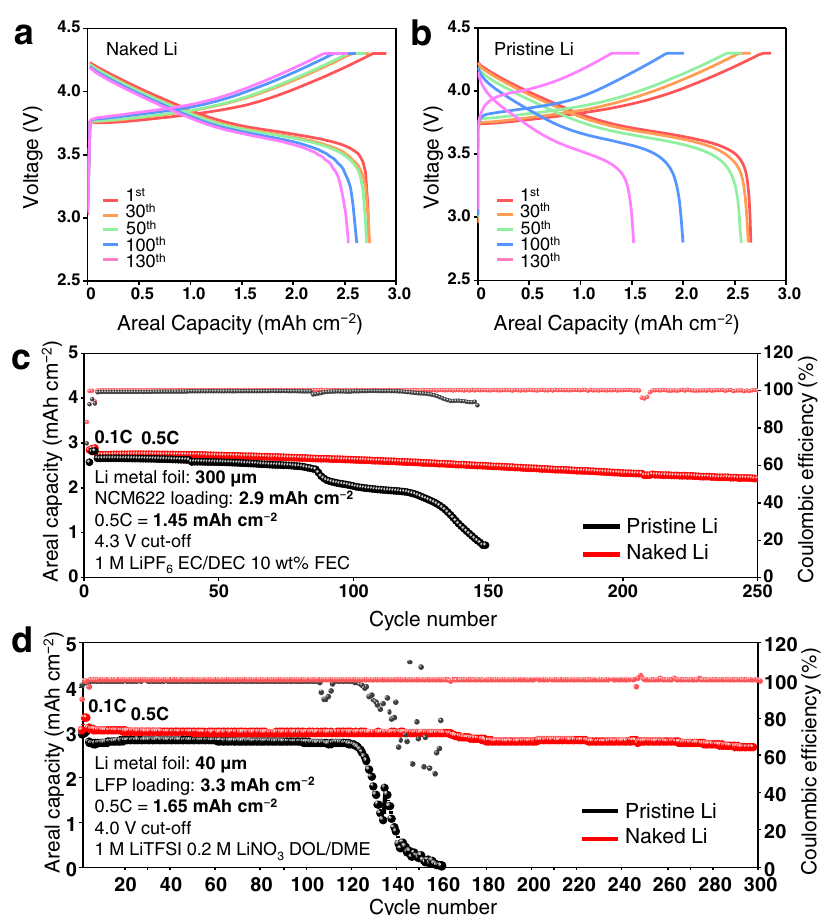
Fig.6|Electrochemicaltestresultsoffullcells. Galvanostaticpotentialpro fi lesof the full cells fabricated with 2.9mAh cm − 2 NCM622 as cathode and 300 µ m thick a , naked and b , pristine Li metal foils as anodes for a different number of cycles. c DischargecapacityandCoulombicef fi ciencyagainstthecyclenumberoffullcells with 2.9mAh cm − 2 NCM622 as the cathode and 300 µ m pristine (black) and naked (red)Limetalfoilsasanodes.1MLiPF 6 inEC/DEC(50/50=v/v)with10wt%FECwas used as electrolyte and the cells were cycled at 0.5C (1.45mAcm − 2 ) after 3 pre-